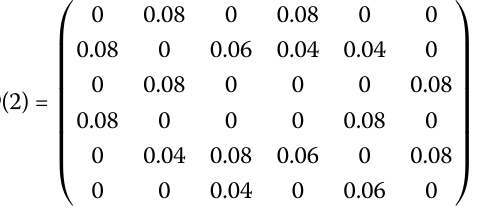
Two new digraphs ( G , D (1)) and ( G , D (2)) are shown in Fig. 2. Obviously, they are strongly